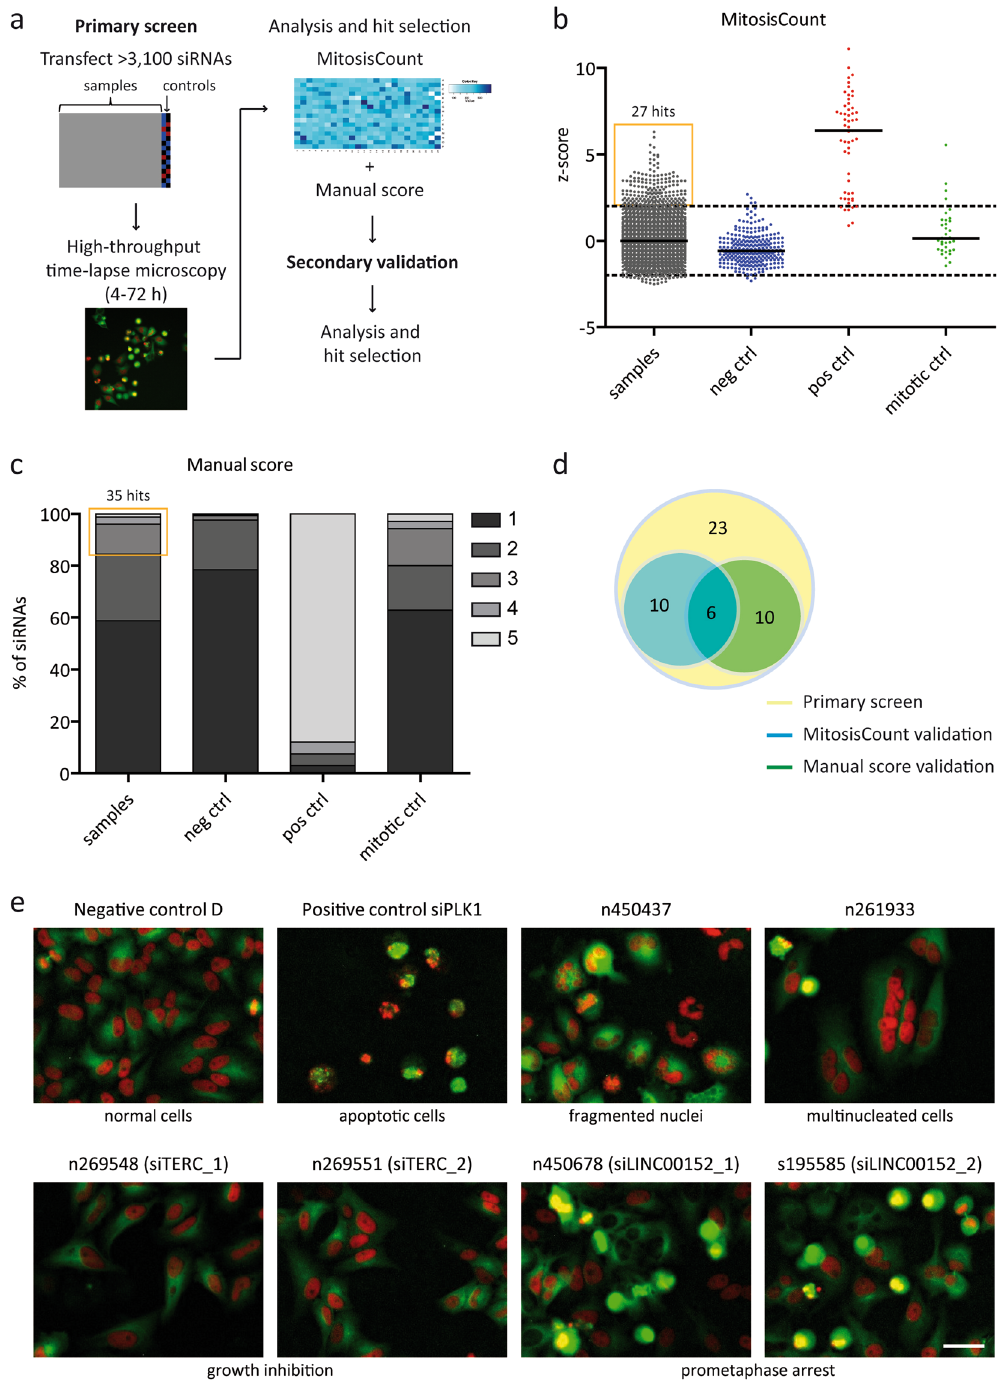
Figure 1. High-throughput RNA interference screen for cell cycle regulators. ( a ) Schematic overview of the siRNA screening strategy. ( b ) Bioinformatical analysis was performed by calculating the z-scores for MitosisCount. Black lines represent the median of z-scores. Dashed lines indicate the cut-off for potential phenotypes. ( c ) Manual analysis was accomplished by assigning a manual score representing the strength of any kind of aberrant phenotype. 1 = normal; 5 = strong phenotype. ( d ) Venn diagram of hits from the primary screen and secondary validation. ( e ) Image sections of exemplary phenotypes discovered by time-lapse microscopy (red: histone H2B, green: tubulin). The siRNA IDs are stated above the images, phenotypes are described below the images. Images were acquired at 10x magnification. Scale bar represents 100 μ